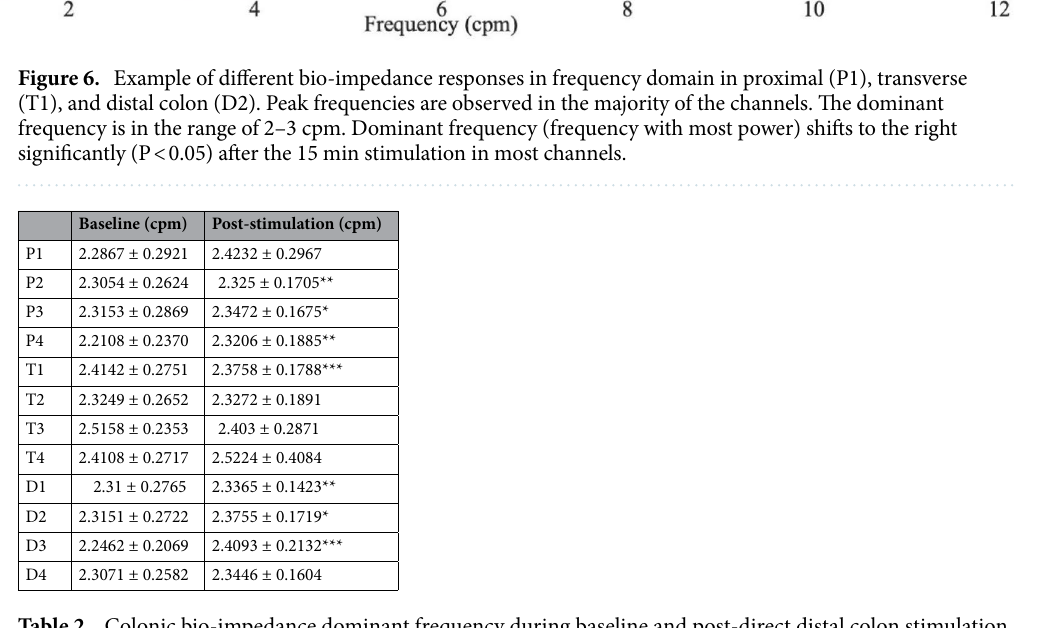
Table 2. Colonic bio-impedance dominant frequency during baseline and post-direct distal colon stimulation in anesthetized male Yucatan minipigs. Data are mean ± SD of n as indicated for each channel. *P < 0.05, **P < 0.01 and ***P < 0.001 vs